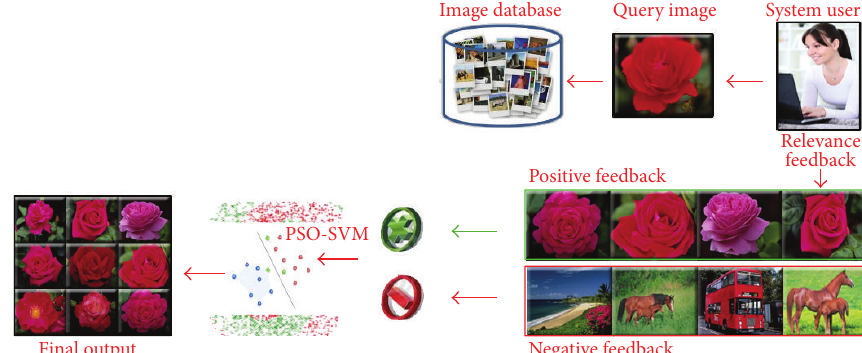
Figure 2: Architecture of the